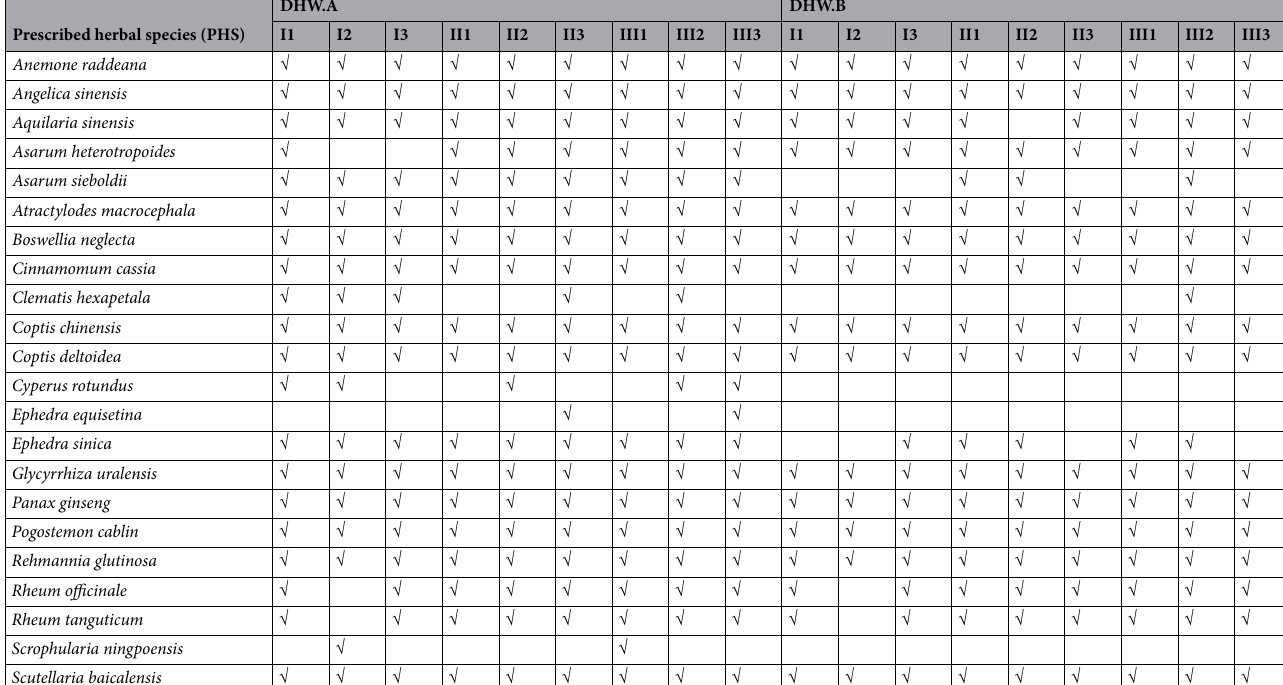
Table 6. Prescribed herbal species for DHW preparation and their presence in each sample by the multi- barcode sequencing approach based on trnL